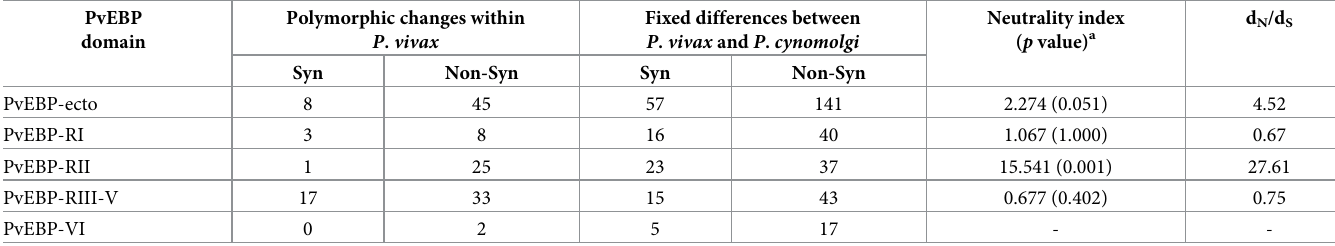
Table 2. McDonald-Kreitman (MK) tests on PvEBP with PcyDBP2 as out-group species and d N /d S ratio.